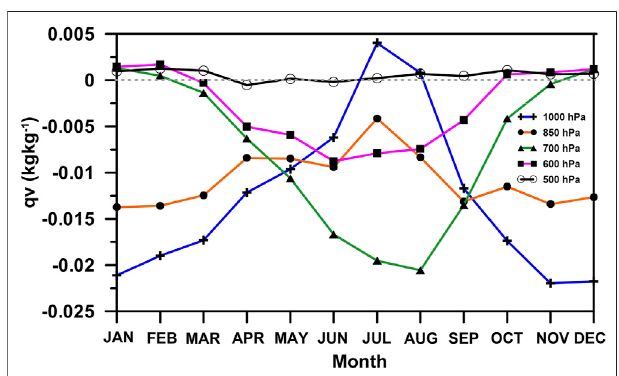
FIGURE 8 | Monthly variation in the study region ’ s area weighted mean moisture fl ux (qv) at different pressure